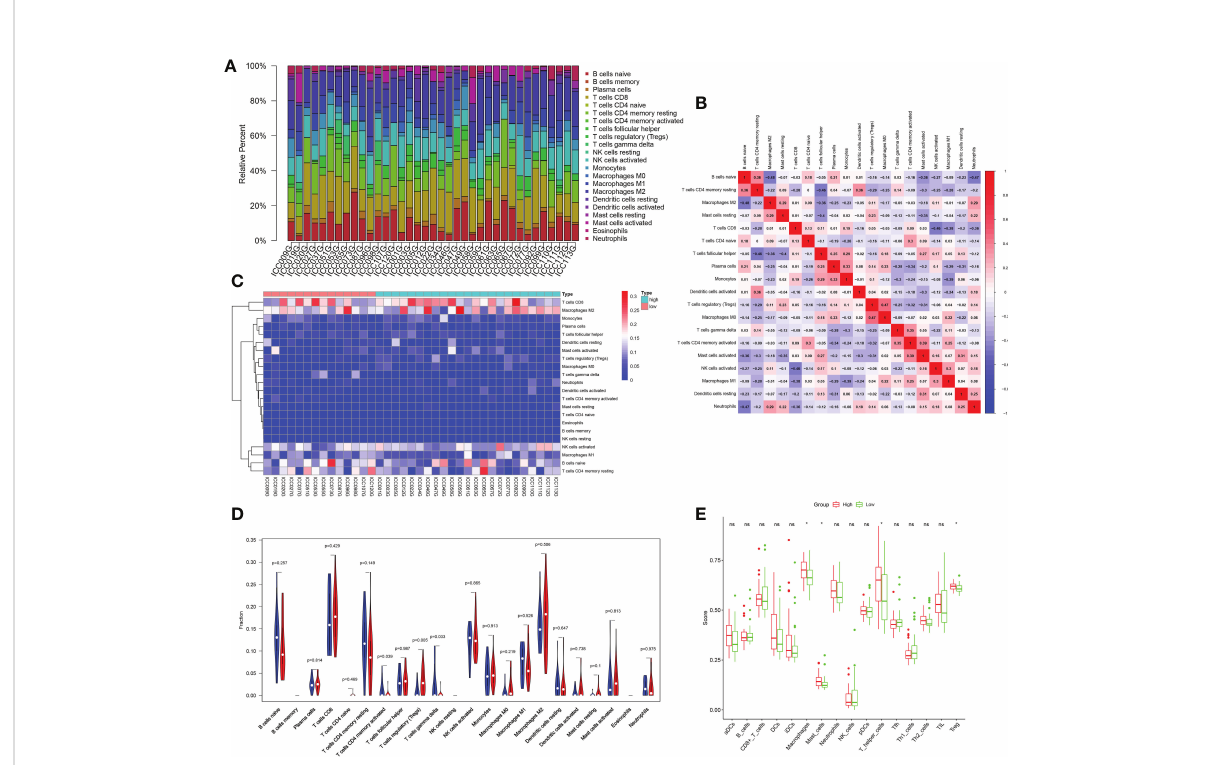
FIGURE 6 Analysis of the immune microenvironment. (A) Bar plot showing the proportion of different immune cells in each sample. (B) The corheatmap demonstrated the correlations among different in fi ltrated immune cells. (C) Heatmap showing in fi ltrated immune cells in the high- and low-risk groups. (D) Comparison of immune cell in fi ltration scores between the low- and high-risk groups estimated by CIBERSORT (red: high risk; blue: low risk). (E) Comparison of immune cell in fi ltration scores between the low- and high-risk groups estimated by ssGSEA (red: high risk; green: low risk). *p < 0.05; ns p >